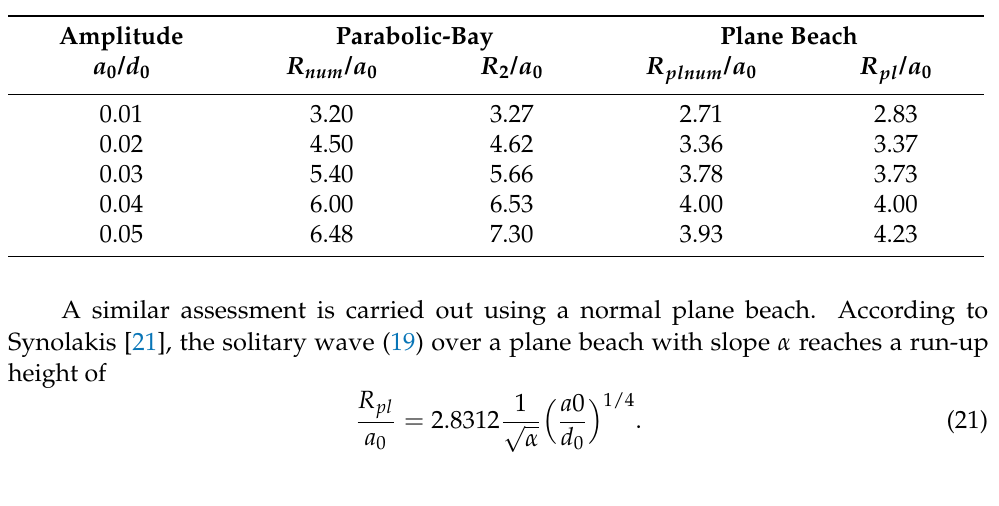
and plane beach, comparison 2